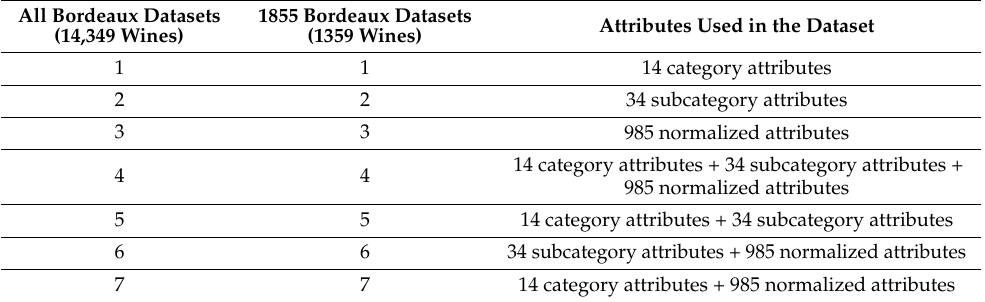
Table 2. Selected attributes in each dataset.